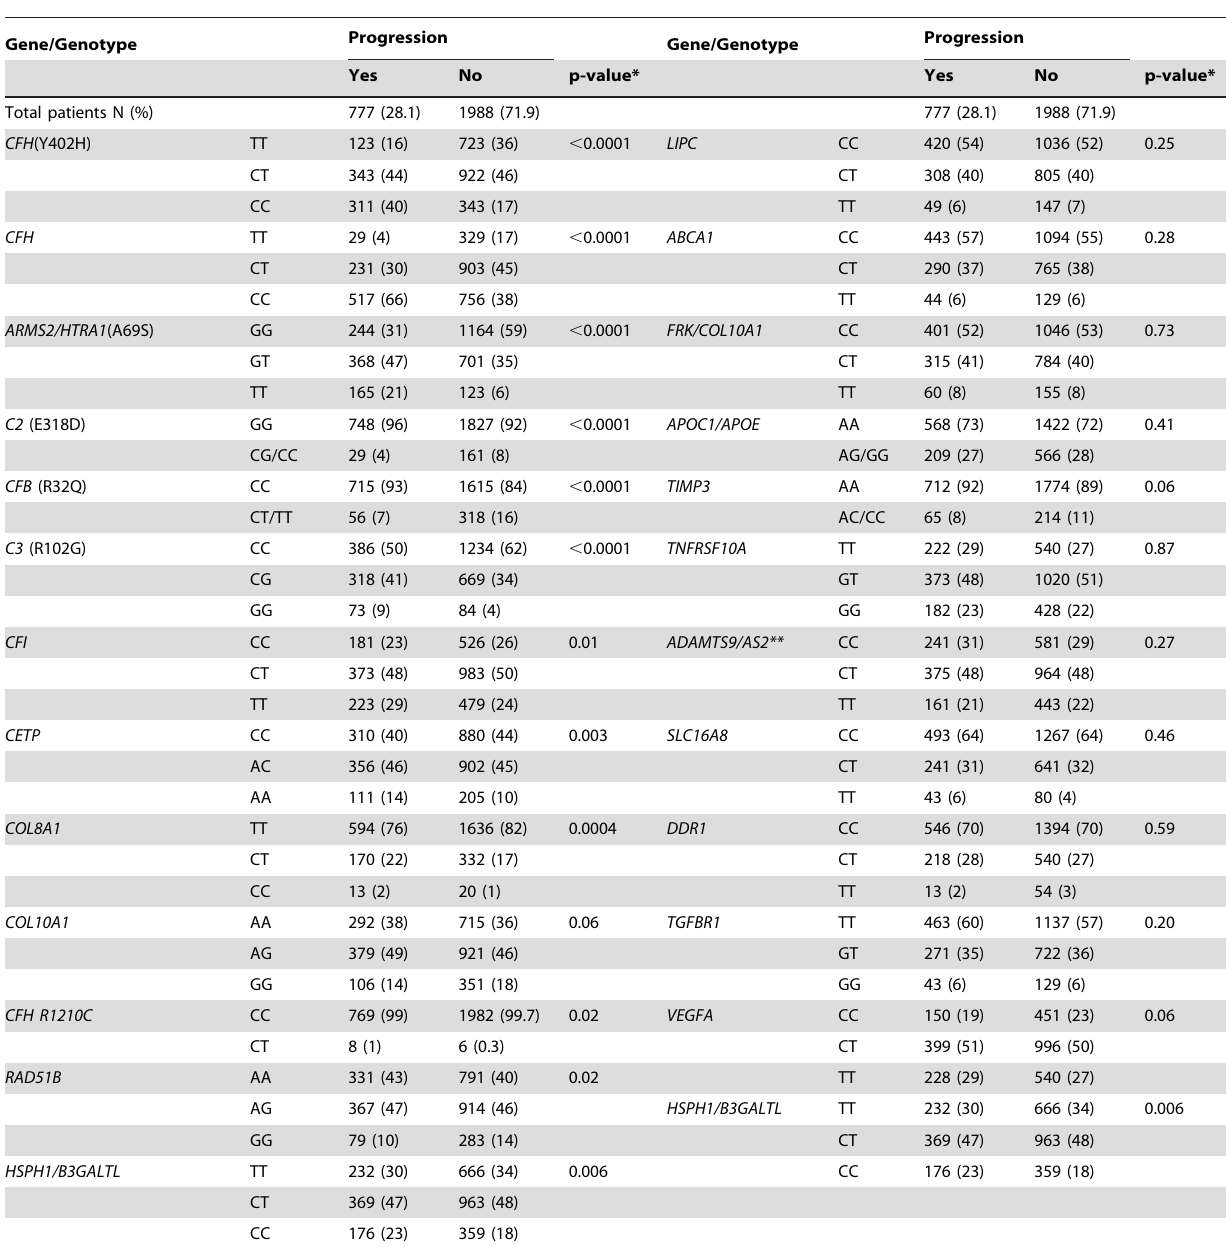
Table 2. Distribution of Age-Related Macular Degeneration Genetic Variants Among Progressors and Non-Progressors.